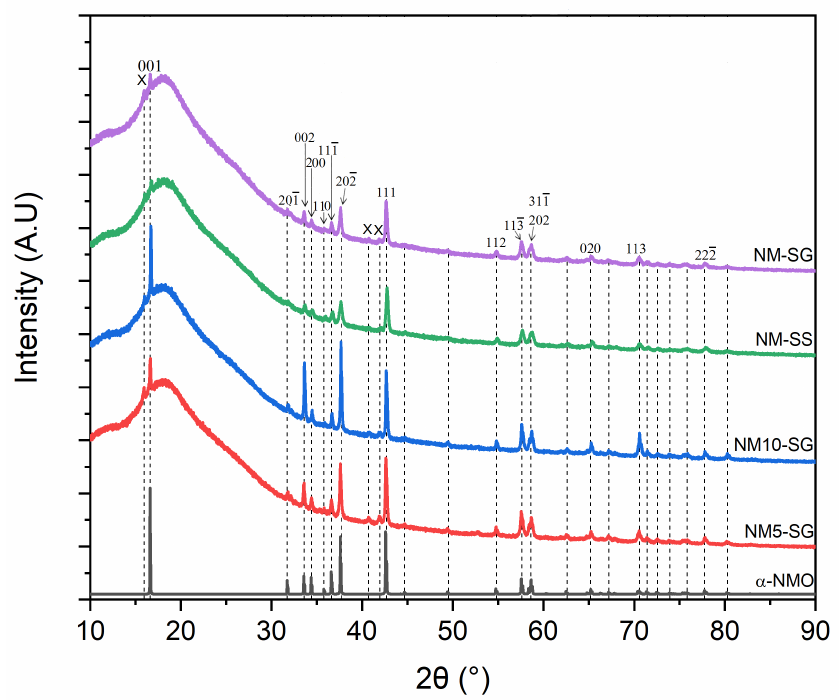
Figure 1. Experimental XRD patterns for all samples compared to theoretical one ( α -NaMnO 2 ) calculated by VESTA [39] using structural data from Ref. [30]. Peaks due to impurities are indicated by X.